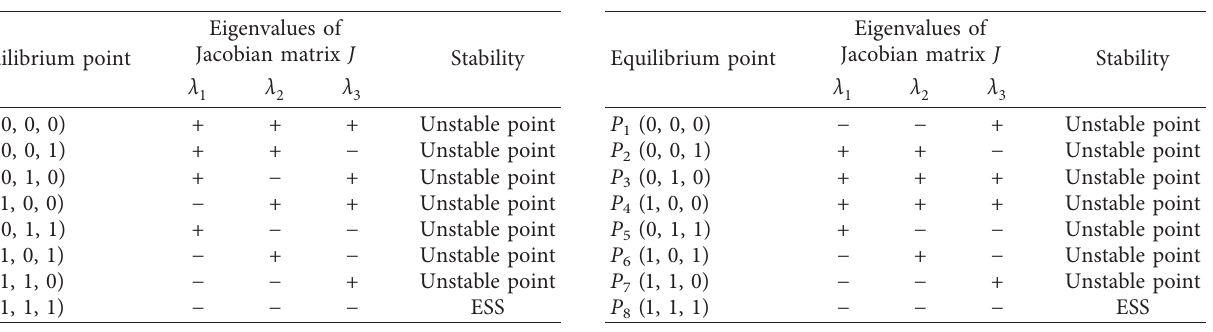
Table 3: Local stability of each equilibrium point based on case (1). Table 4: Local stability of each equilibrium point based on case (2).